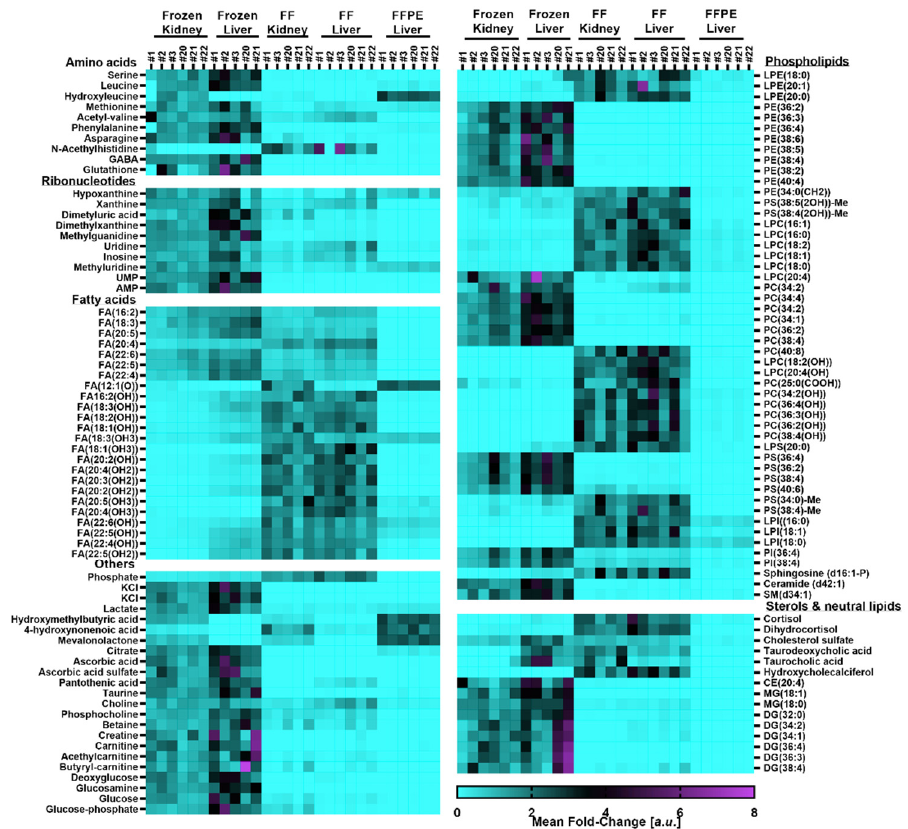
Figure 2. Mean-Fold changes of metabolite abundances as determined by DESI-MSI of fresh-frozen and formalin-fixed rat kidneys and fresh-frozen, formalin-fixed and formalin-fixed, paraffin em- bedded rat liver specimens respectively. Mean-fold changes were calculated to the average of all analyzed specimens in all treatment groups of one organ. The assigned numbers in the header refer to the individual animal IDs (i.e., #1 = Animal 1). Detailed information for the annotations can be found in Table S1. Detailed information regarding statistical significance for the changes can be found in Table